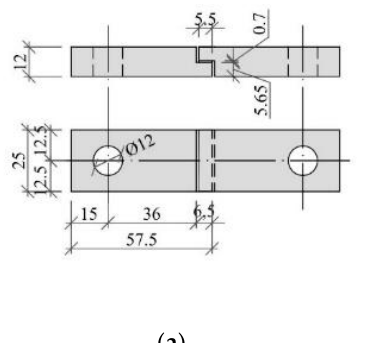
Figure 4. TAST test: ( a ) the geometry of tested specimen; ( b ) the stress-strain relationship (indirectly determined). The line colors were assigned to the next five identical samples